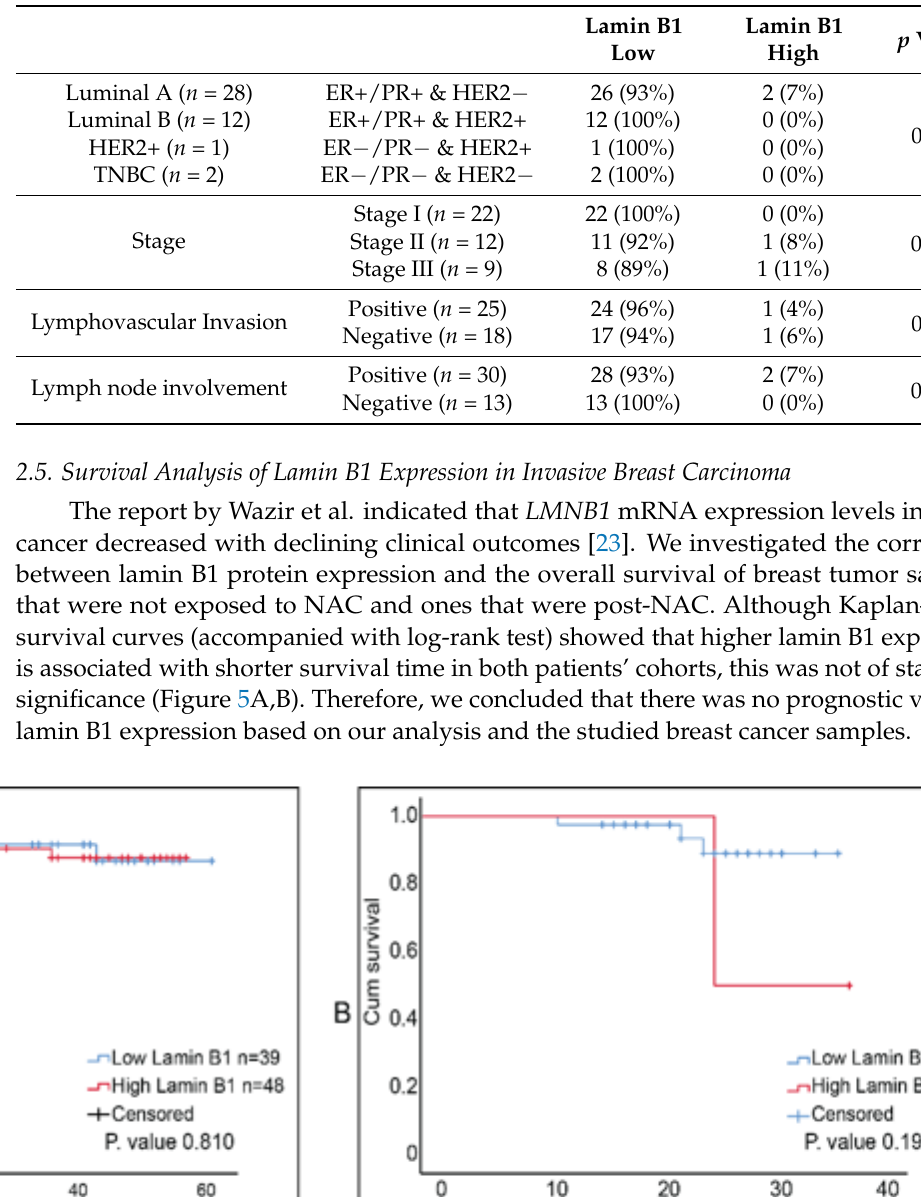
Table 3. Association of lamin B1 expression and clinicopathological variables of invasive breast carcinoma tissue after exposure to NAC (Group C, n = 43). The table depicts the statistical analysis of the association between lamin B1 expression in malignant breast cancer tissue and patients’ clinicopathological characteristics. Group C breast cancer samples were exposed to NAC. p values were calculated using Pearson’s Chi-square or Fisher’s exact non-parametric tests.